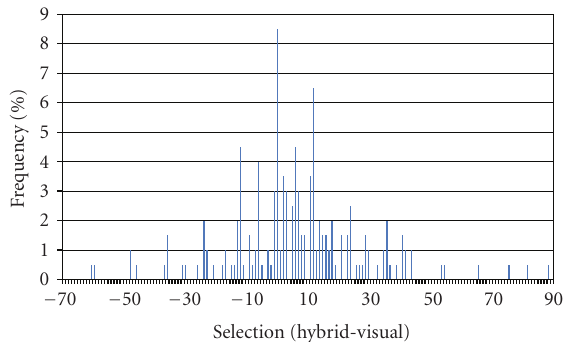
Figure 19: Histogram of the clicks. The horizontal axis stands for the number of clicks (positive for hybrid ranking and negative for visual), while the vertical for the frequency.